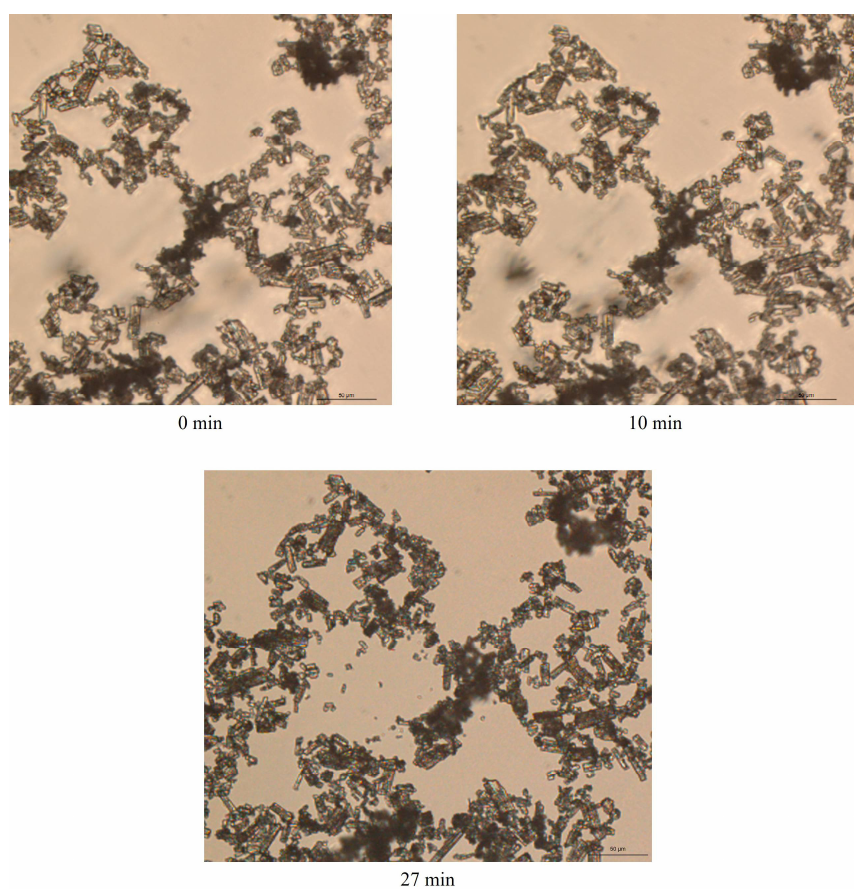
Figure 9. Optical microphotographs of the same field of the grains of posaconazole API Form I 0 min, 10 min and 27 min after being wetted with type II water on an object glass slide using transmission mode, brightfield illumination and 20× objective lens (200 magnification).